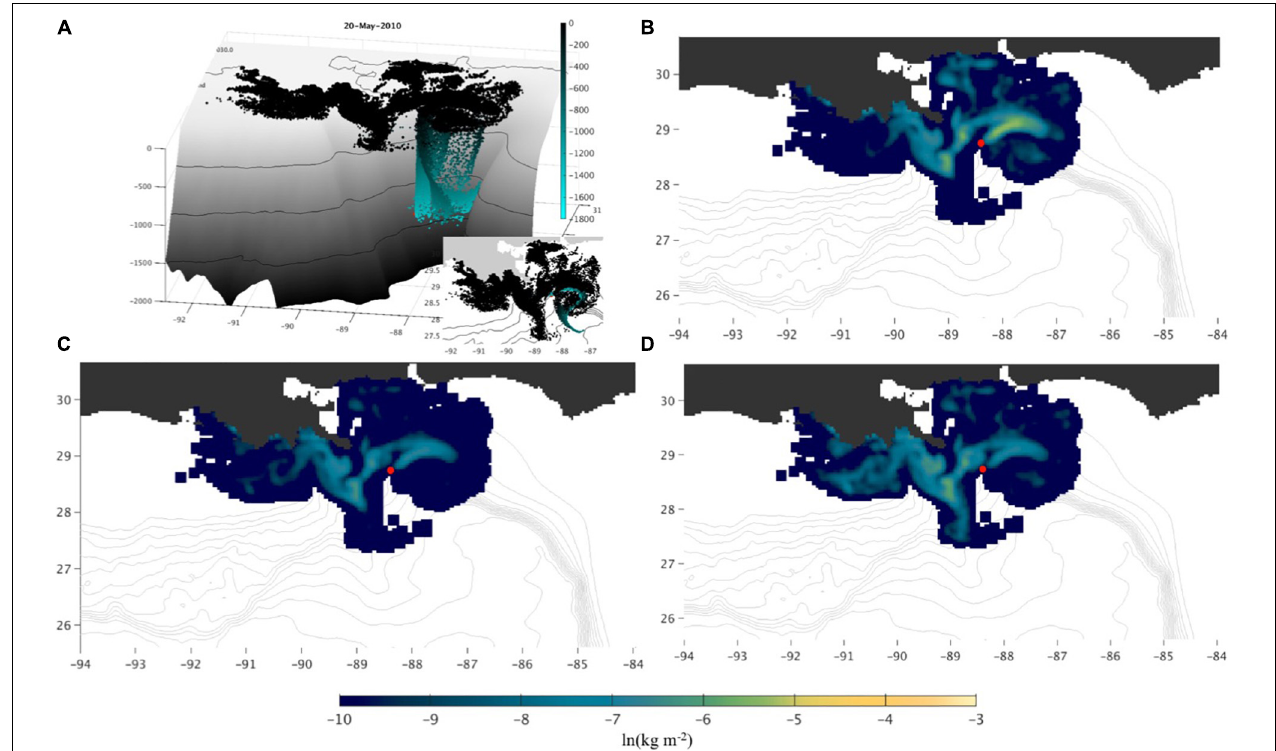
FIGURE 9 | Simulated oil from the test experiment with the fully coupled ROMS-OTWM-OPAMOD-Biogeochemical model after 30 days of simulation. (A) Three-dimensional distribution of Lagrangian floats representing clusters of oil particles. The red dot indicates release location at the bottom. Colors designate particles’ depth in the water column. (B–D) Mass density (kg m − 2 ) of the oil compounds (saturates, aromatics, resins and asphaltenes, respectively) in the upper 50 m. Mass density is on the natural logarithmic